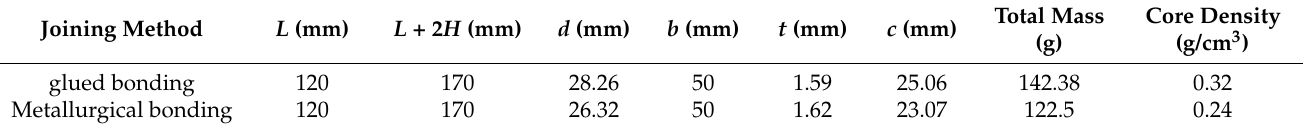
Table 2. Dimension of specimen geometry was considered during the three-point bending test.